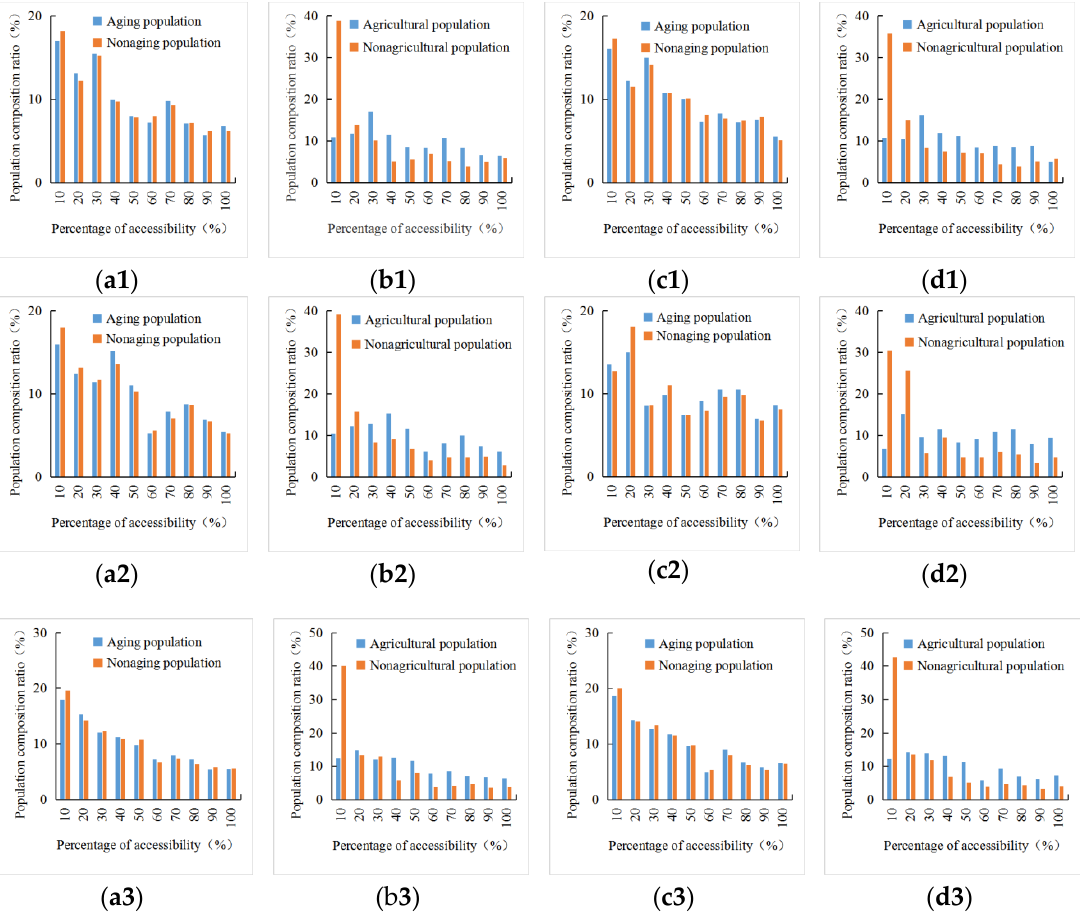
Figure 7. Differences of ( a1 ) Pri_T; ( a2 ) Sec_T; ( a3 ) Ter_T; ( c1 ) Pri_S; ( c2 ) Sec_S; ( c3 ) Ter_S between aging and nonaging populations, and ( b1 ) Pri_T; ( b2 ) Sec_T; ( b3 ) Ter_T; ( d1 ) Pri_S; ( d2 ) Sec_S; ( d3 ) Ter_S between agricultural and nonagricultural populations in Shaanxi.